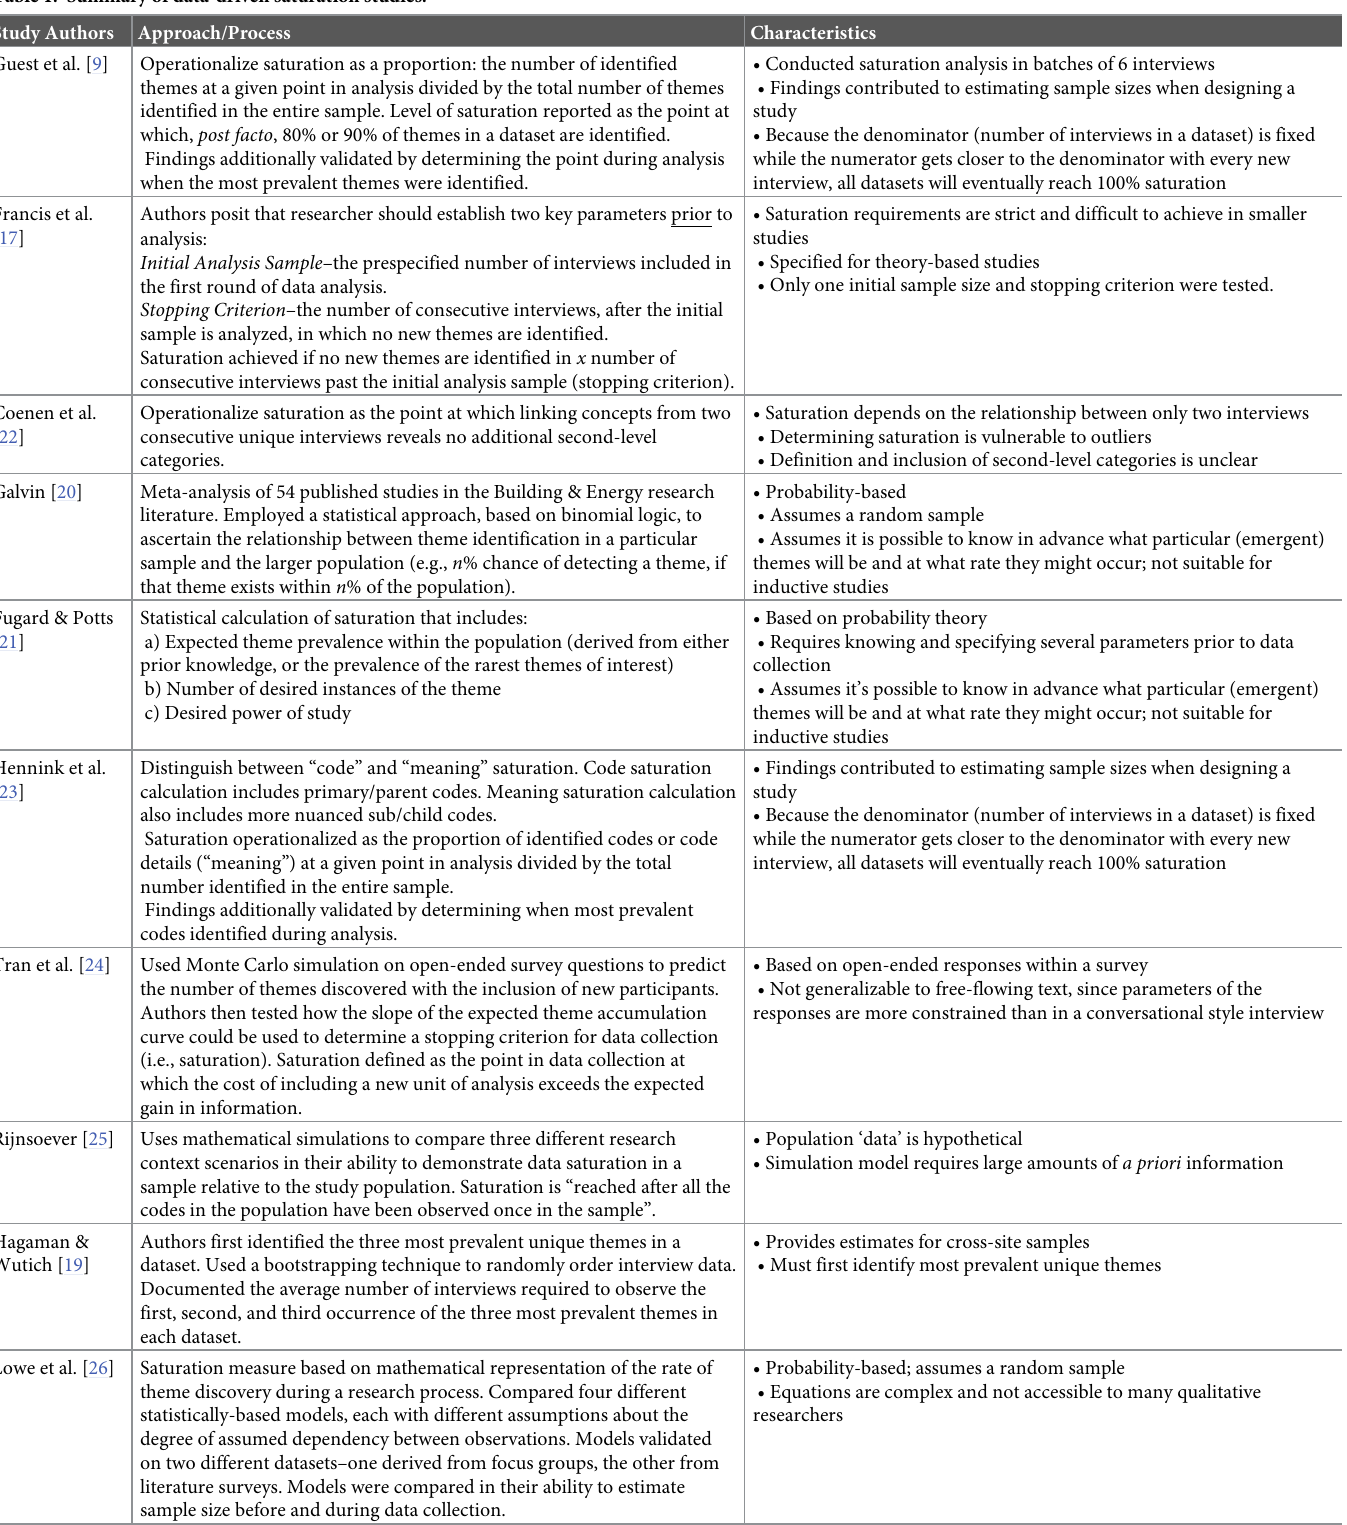
Table 1. Summary of data-driven saturation